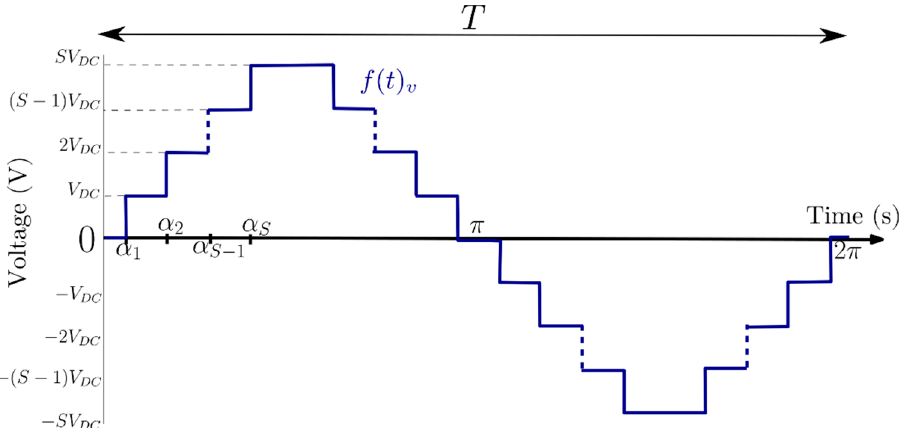
Figure 17. Single phase multilevel inverter staircase output waveform [15].